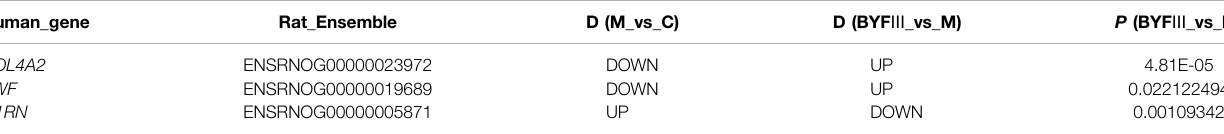
Note. D (M_vs_C) denotes the dysregulation direction of genes in rat COPD model compared with rat control data; D (BYF Ⅲ _vs_M) denotes the dysregulation direction of genes in rat COPDmodelafterECC-BYF Ⅲ treatmentcomparedwithCOPDmodeldatawithouttreatment; P (BYF Ⅲ _vs_M)denotesthe p- valuebetweenratCOPDmodeldatawithandwithoutECC- BYF Ⅲ treatment by edgeR